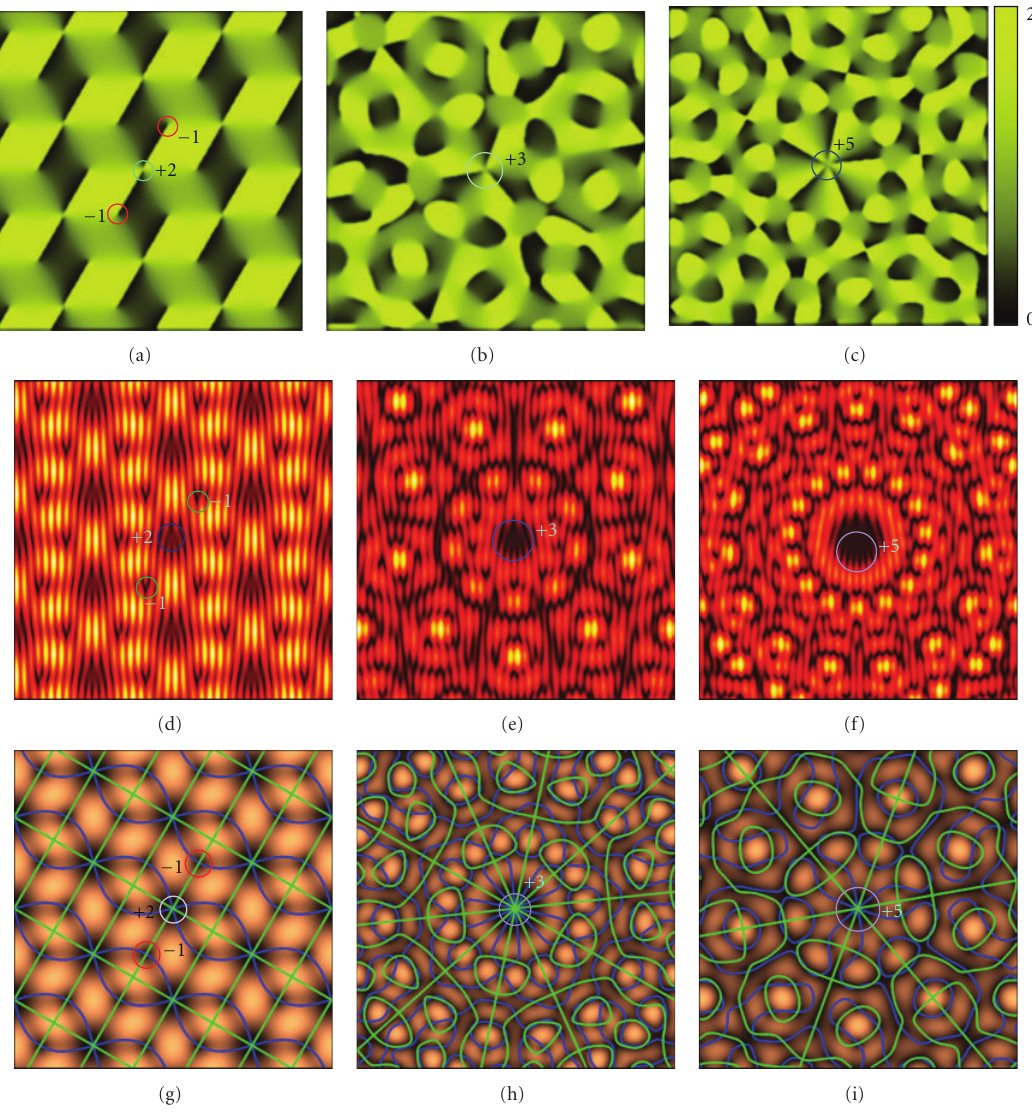
Figure 3: Computational analysis of complex 2D vortex lattices. Taking the multiples of relatively phase-shifted three beams, the numbers of interfering beams involved are, respectively, 6 beams (first column), 9 beams (second column), and 15 beams (third column). (a)–(c) Phase profile. (d)–(f) The fork formation while the pattern is interfered with a plane wave launched at a large angle from the axis. (g)–(i) Zero crossing plot (blue line: zeros of Re E ( r ) and green line: zeros of Im E ( r )). Circle at the center in cyan color highlights the higher-order